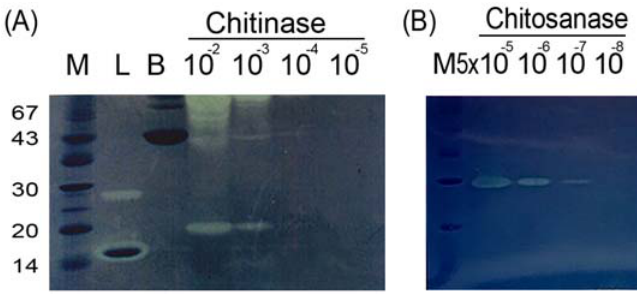
Figure 1. The sensitivities of in-gel chitinase assay using serial dilution of units of Streptomyces griseus chitinase ( A ) and chitosanase assay using Streptomyces sp. chitosanase ( B ). Lane M, protein markers; Lane L, lysozyme, as positive control; Lane B, bovine serum albumin, as negative control.